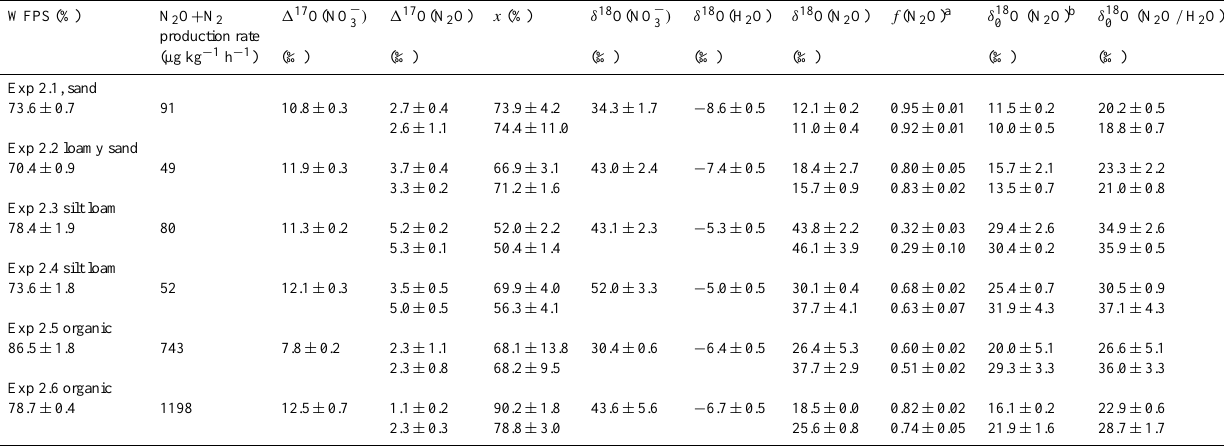
Table 2. Exp 2 results: soil moisture (expressed as water-filled pore space: WFPS), N 2 O + N 2 production rate (expressed as mass of N as sum of N 2 O and N 2 per mass of dry soil per time), 17 O excess in soil nitrate ( (cid:49) 17 O(NO 3 )) and in N 2 O ( (cid:49) 17 O(N 2 O)) with calculated exchange with soil water ( x) and oxygen isotopic signature ( δ 18 O) of soil nitrate (NO 3 ) , soil water (H 2 O) and N 2 O. All δ 18 O(N 2 O) values were corrected taking into account N 2 O mole fraction ( f (N 2 O)) to calculate the values unaffected by N 2 O reduction ( δ 18 respective δ 18 O(N 2 O / H 2 0